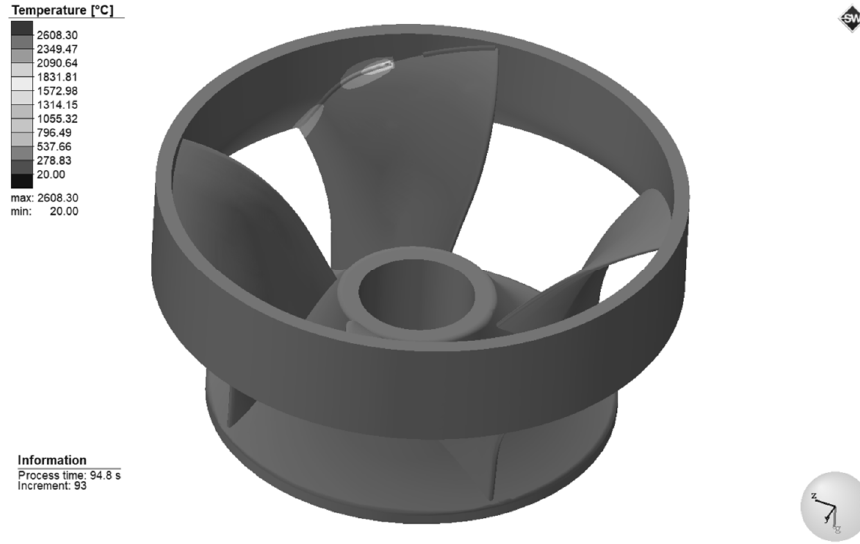
Figure 11. 3D temperature profiles on the outer surface at 94.8 s.